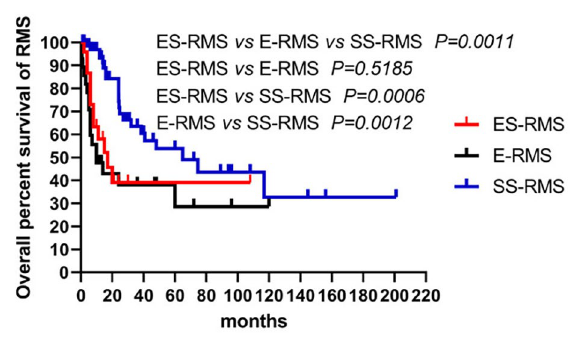
Fig. 5 Prognostic comparisons of RMS. ES-RMS: epithelioid and spindle rhabdomyosarcoma; E-RMS: epithelioid rhabdomyosarcoma; SS-RMS: spindle cell/sclerosing